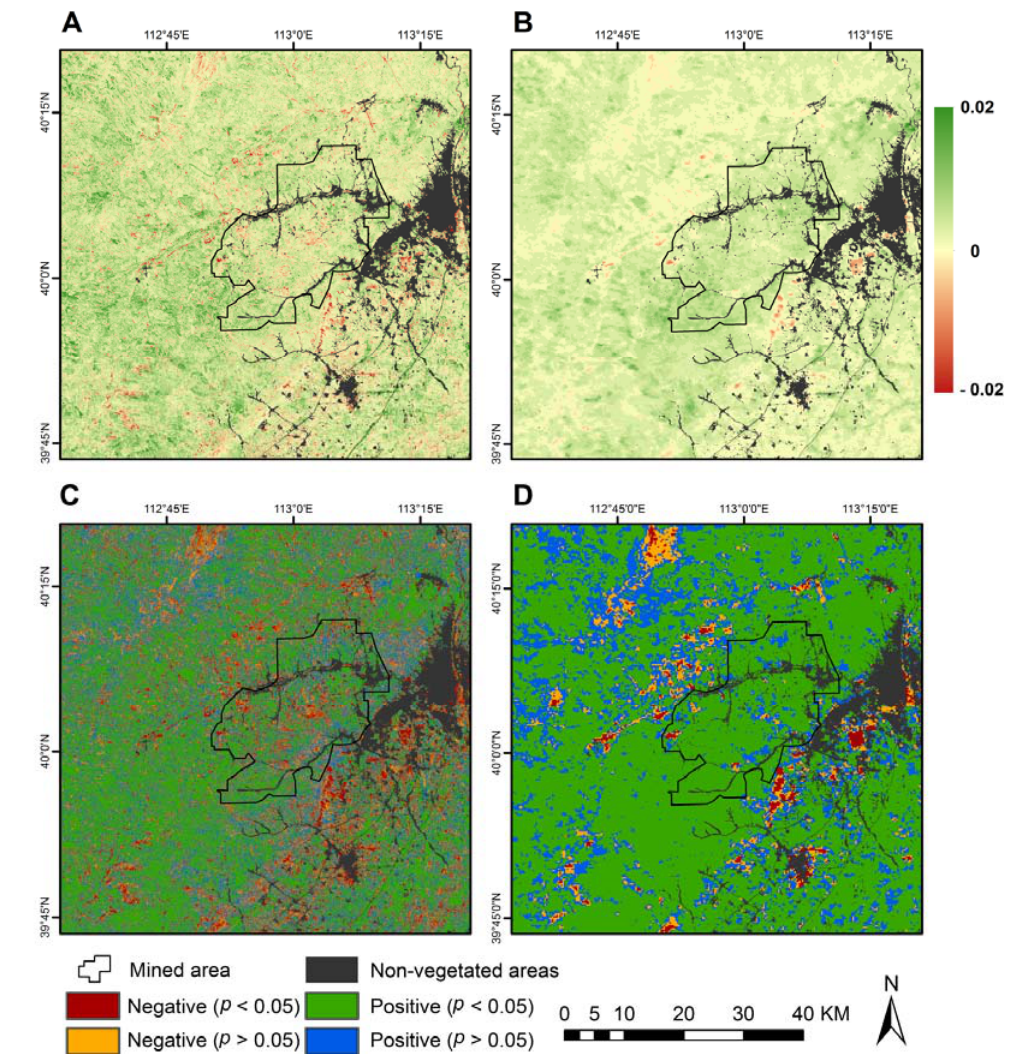
Figure 6. Spatial distribution of NDVI slopes (in NDVI units per year) derived from ( A ) synthetic and ( B ) MODIS dense NDVI time series (2000–2011) and the corresponding significance of the trends according to the seasonal Mann-Kendall test for ( C ) synthetic and ( D ) MODIS time series